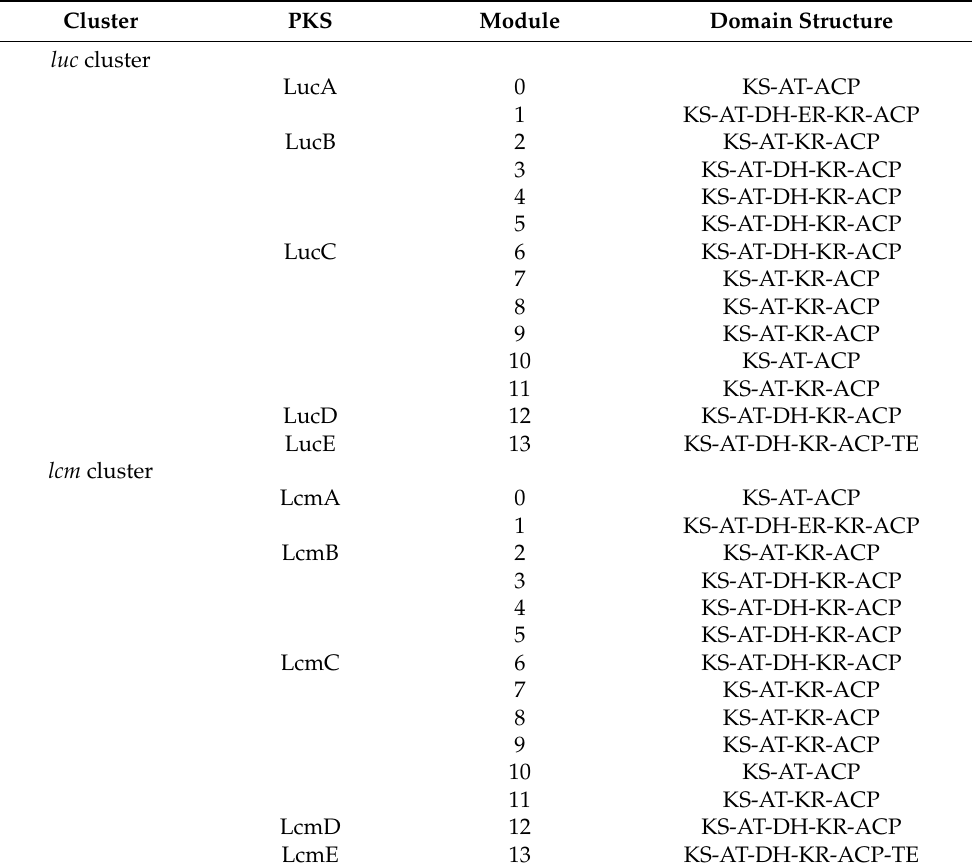
Table 2. Domain structures in each module of PKSs from luc cluster in S. achromogenes subsp. streptozoticus NBRC14001 and lcm cluster in S. cyanogenus